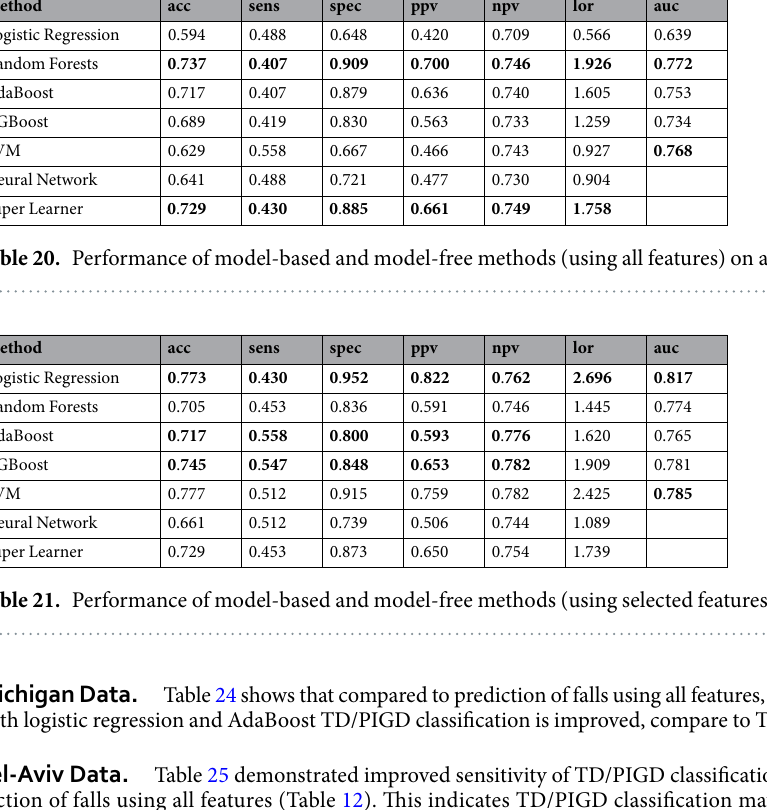
Table 25 demonstrated improved sensitivity of TD/PIGD classification, as compared to pre- diction of falls using all features (Table 12). This indicates TD/PIGD classification may also be an important predictor of patients’ falls.